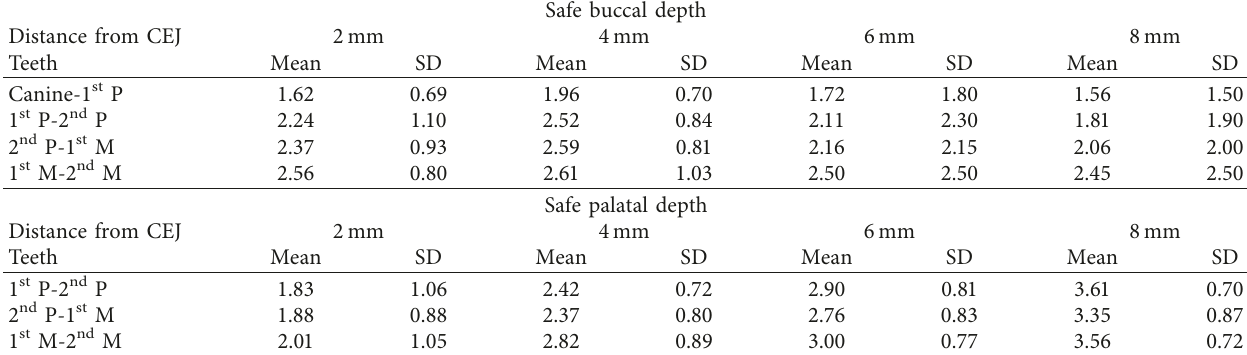
Table 3: Safe buccal and palatal bone thickness in